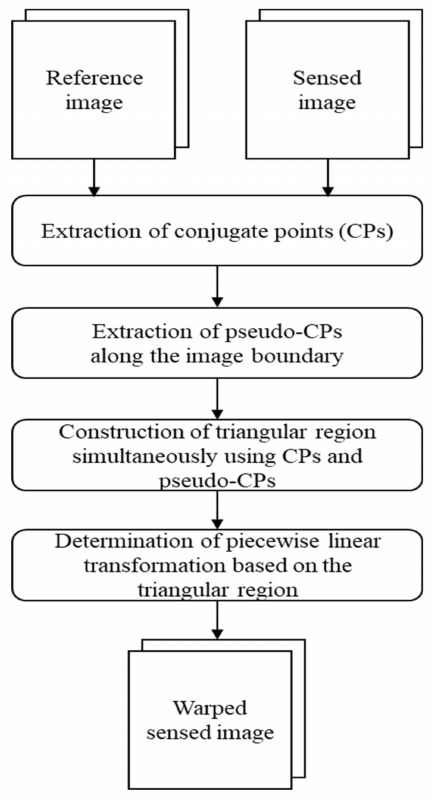
Figure 2. Sequence of tasks for the proposed improved piecewise linear (IPL)